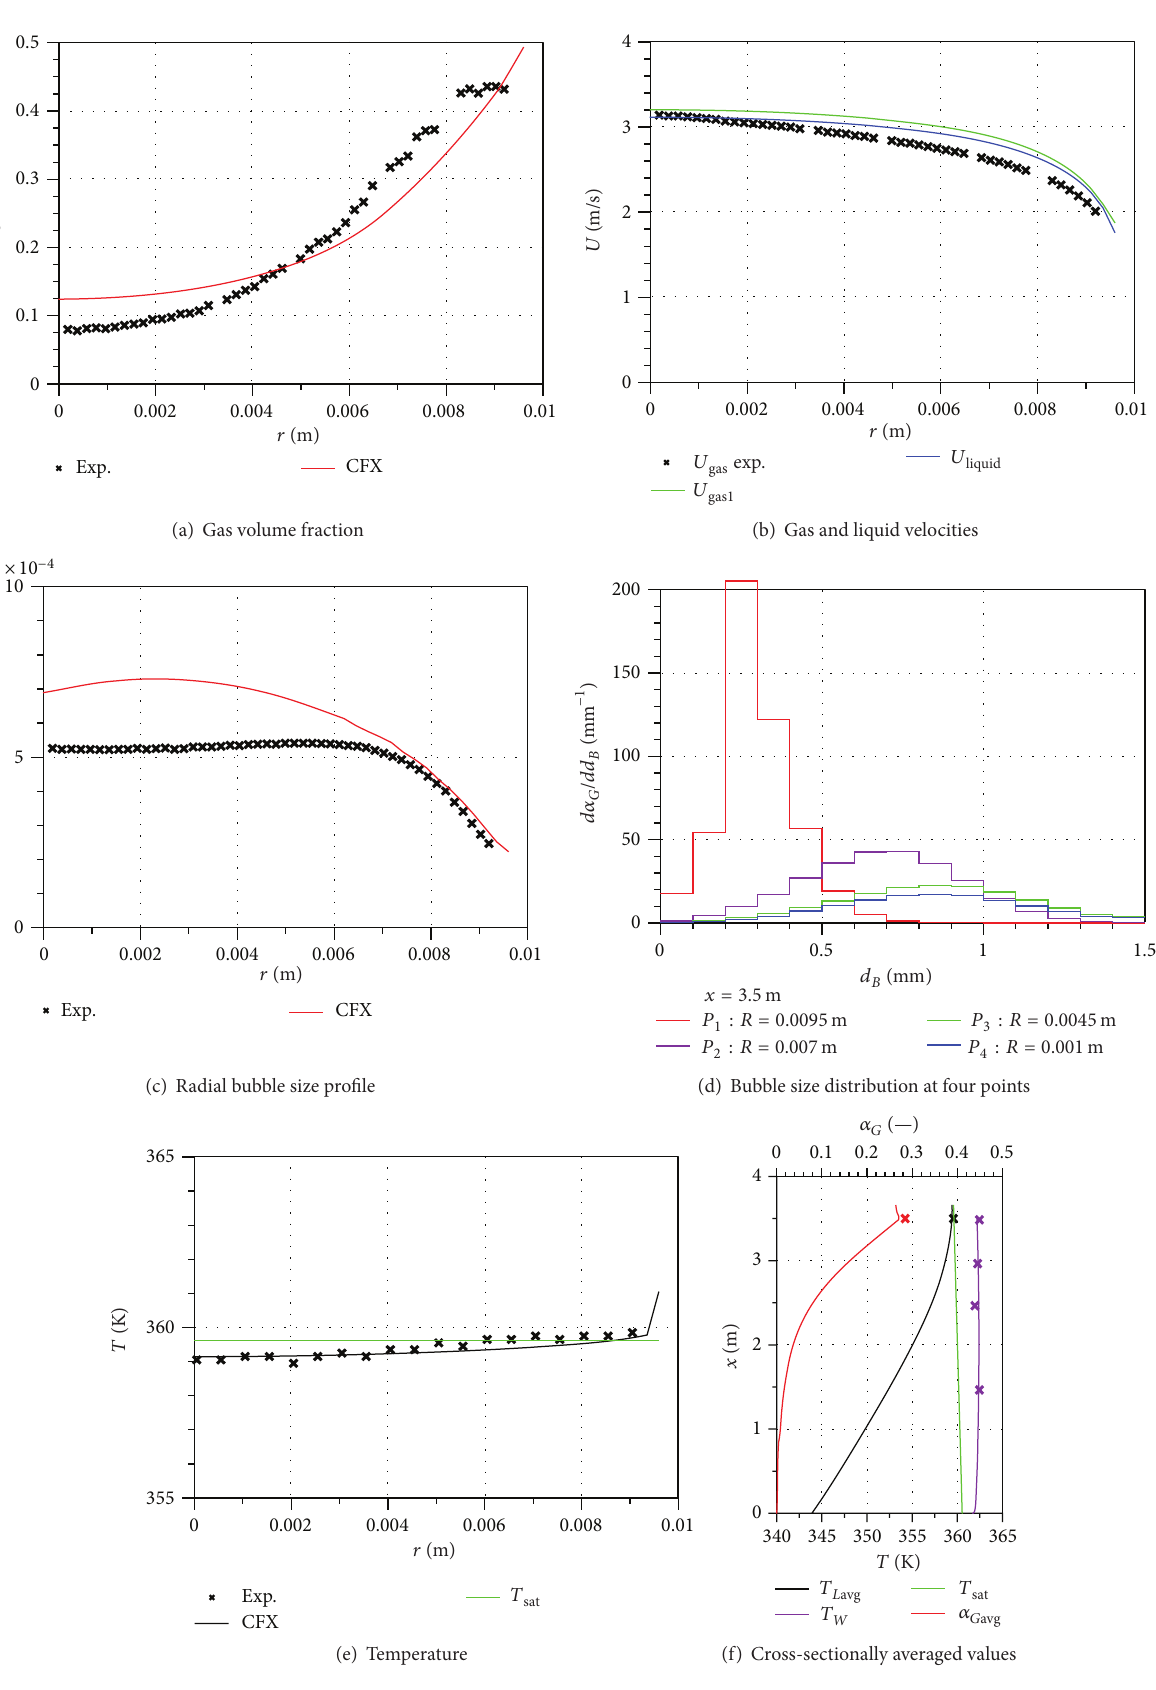
F 6: Comparison of measured and calculated values for P26-G2-Q74-T16: